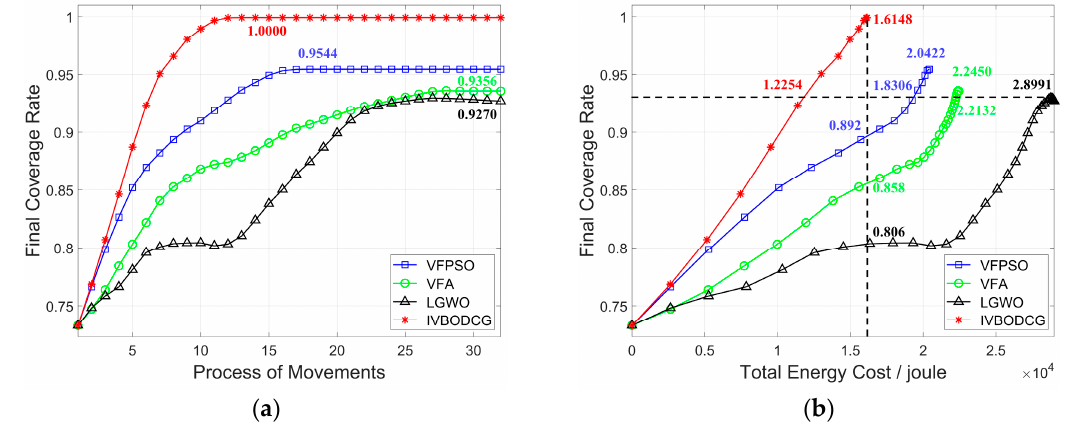
Figure 11. Coverage rates and energy cost of four algorithms. ( a ) shows the relationship between final coverage rate and process of movements. ( b ) shows the relationship between final coverage rate and total energy cost. Compared with VFA, VFPSO and LGWO, IVBODCG can achieve the optimal coverage effect with the least energy cost and the fewest rounds of movements.